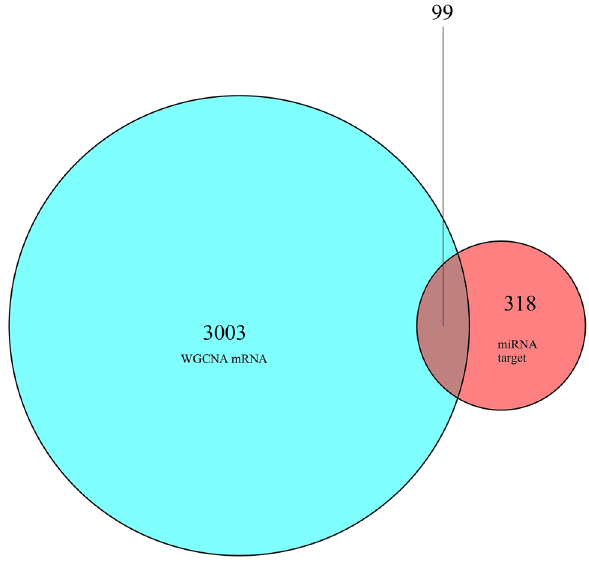
Figure 9. mRNA Venn.